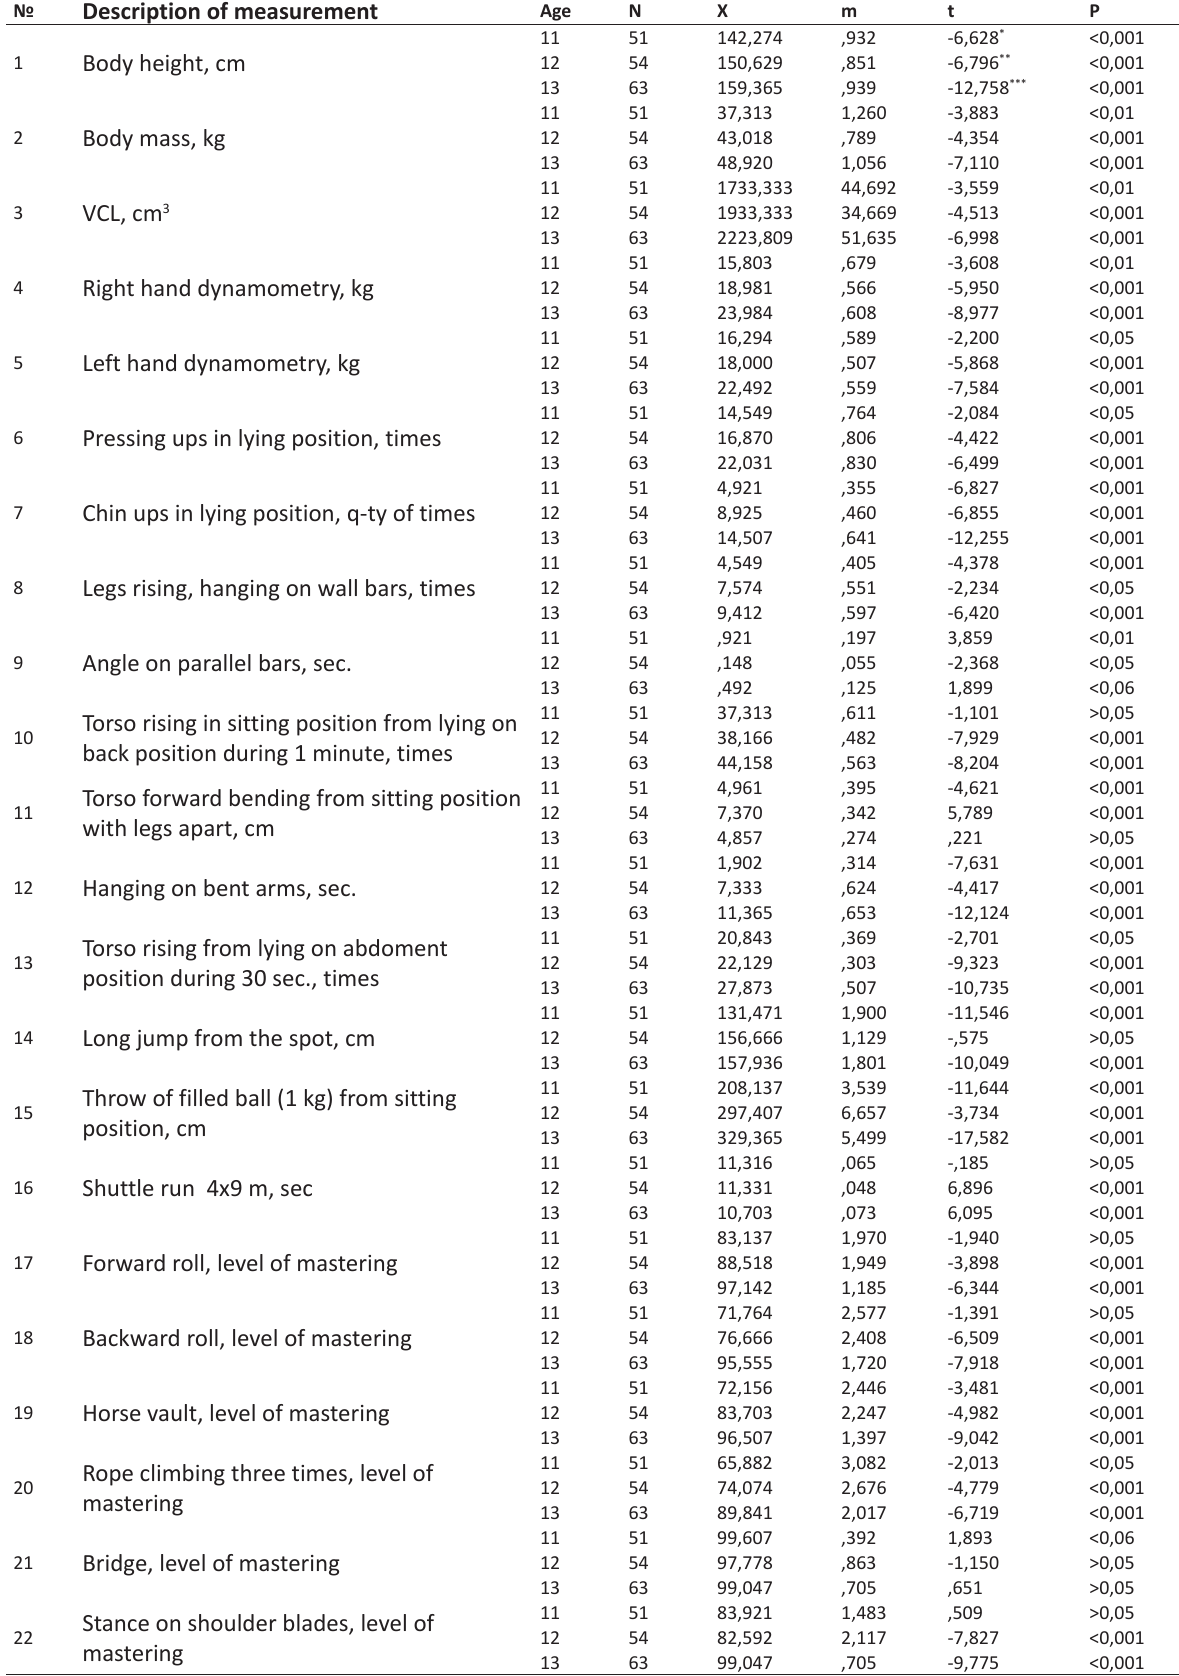
Table 1. Testing results fo 11-13 yrs girls’ motor